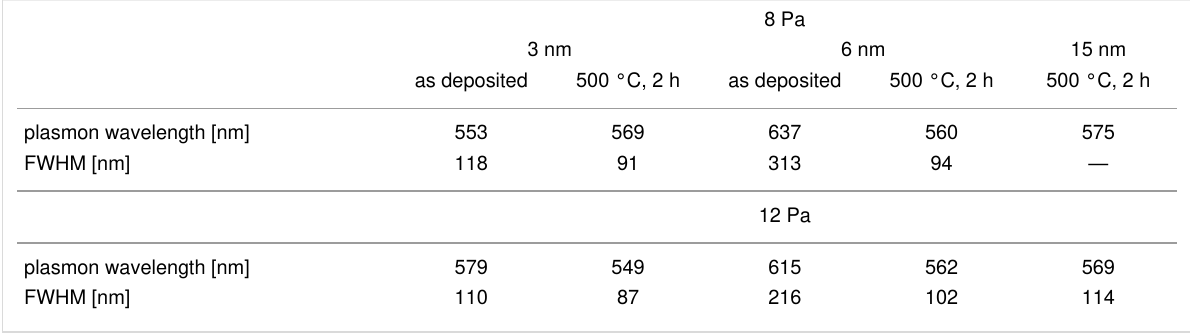
Table 2: LSPR wavelength (minima of transmission spectra) and corresponding FWHM.